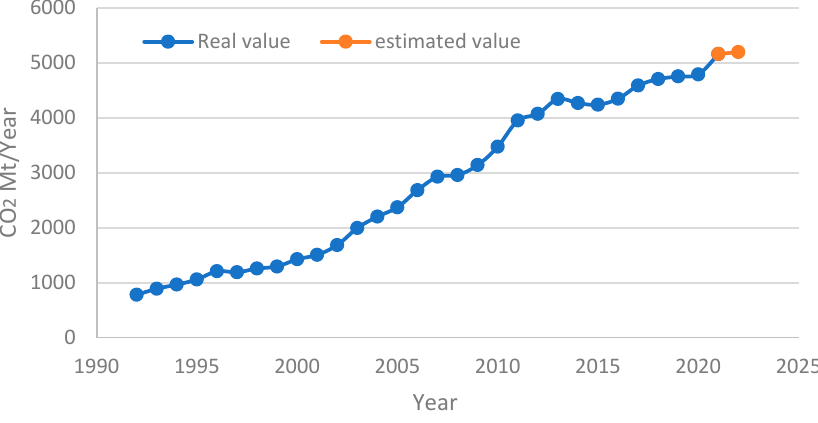
Figure 4. The carbon emissions of China’s power industry from 1992 to 2022.